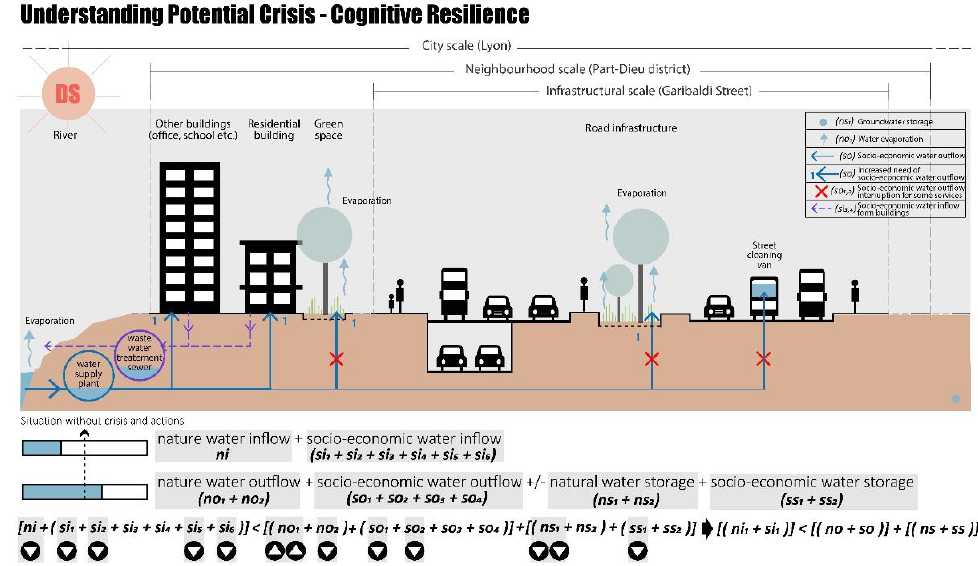
Figure 4. Drought scenario, cognitive resilience in Part-Dieu district, realised by authors.